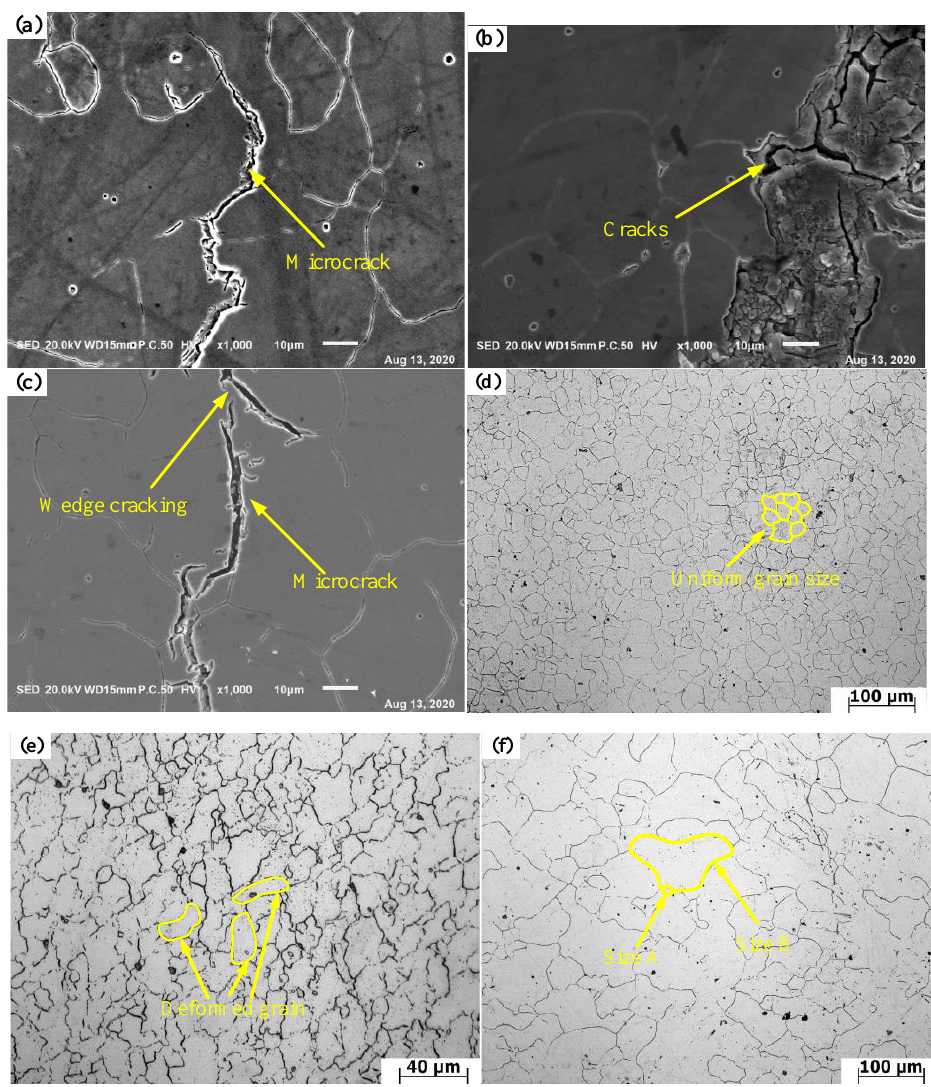
Figure 18. Different regions of the thermal processing map under the condition of a strain of 0.7.